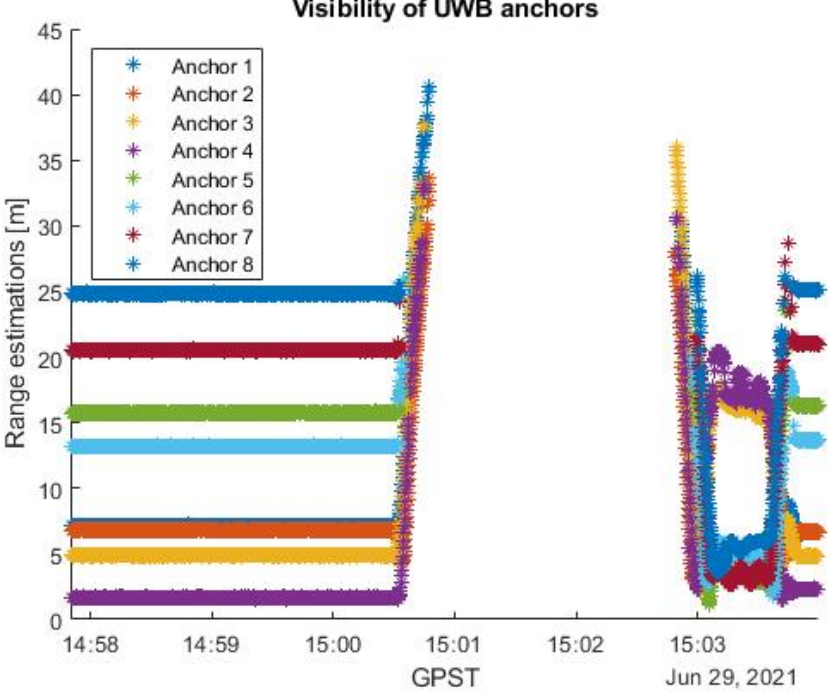
Figure 12. Visibility of UWB signals (round 5).